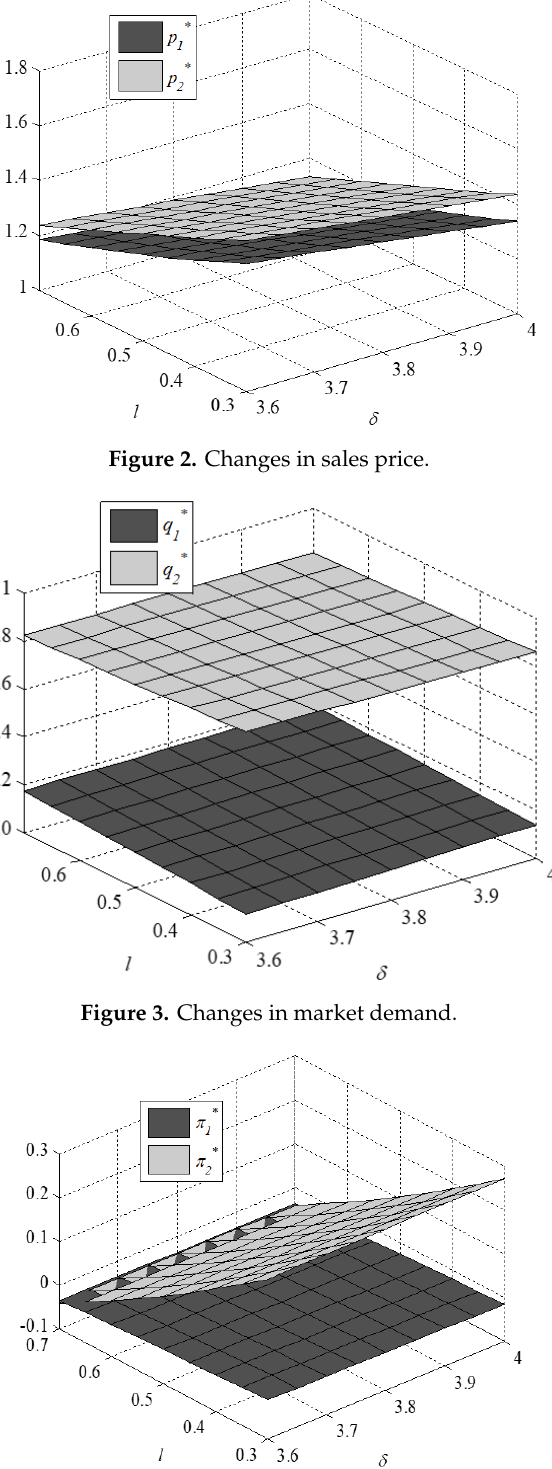
Figure 4. Changes in profit of enterprises.